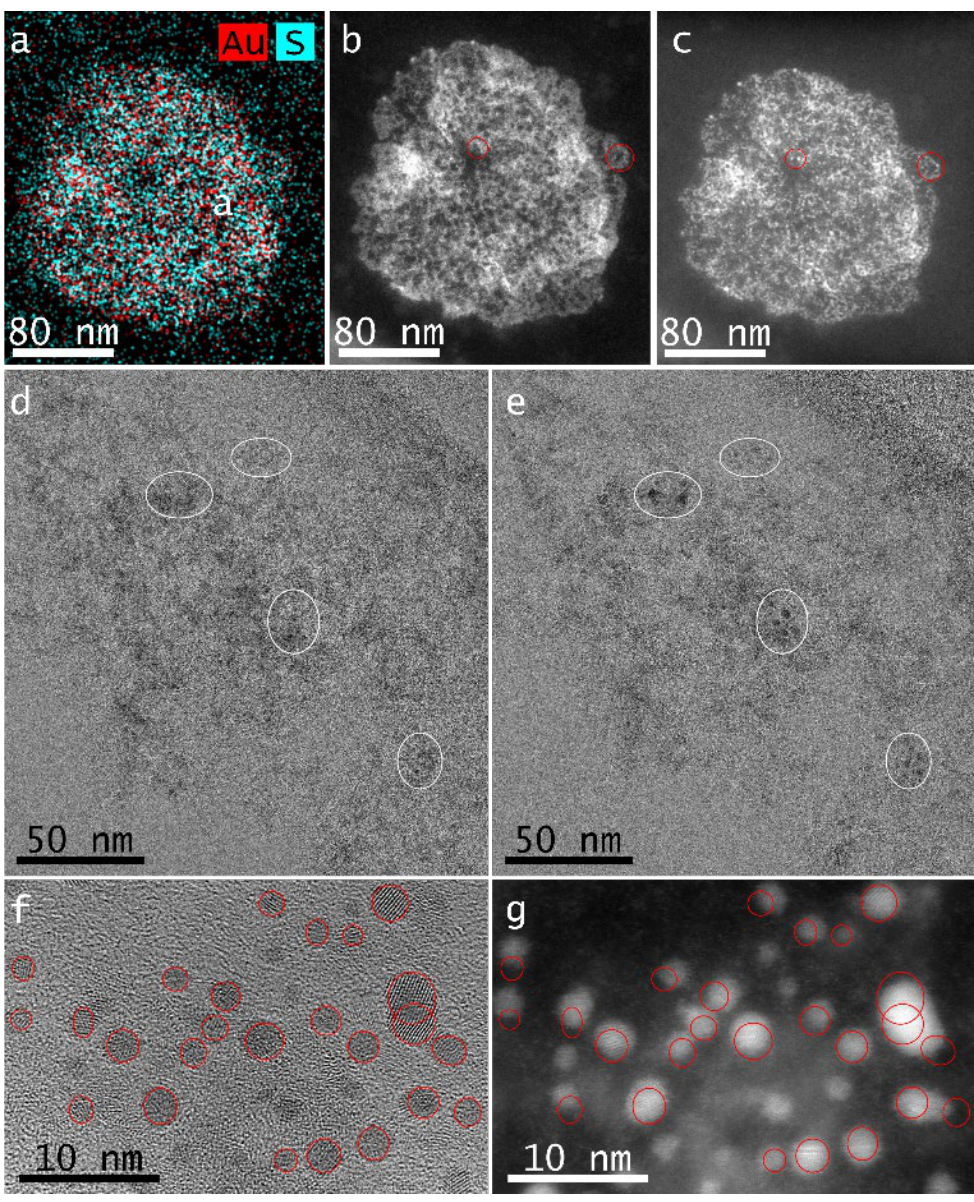
Figure 3. ( a ) Elemental map of Au and S distributions in AuBSA determined by EDS. STEM images of AuBSA prior ( b ) and after ( c ) the performed EDS analysis. HR-TEM images of the same area of AuBSA prior ( d ) and after ( e ) the exploitation of a higher magnification. HR-TEM ( f ) and STEM ( g ) images of the same spot on AuBSA. Colored and/or white circles indicate appearance of new NPs in ( b , c , d , e ) and/or migration of NPs in ( f , g ).